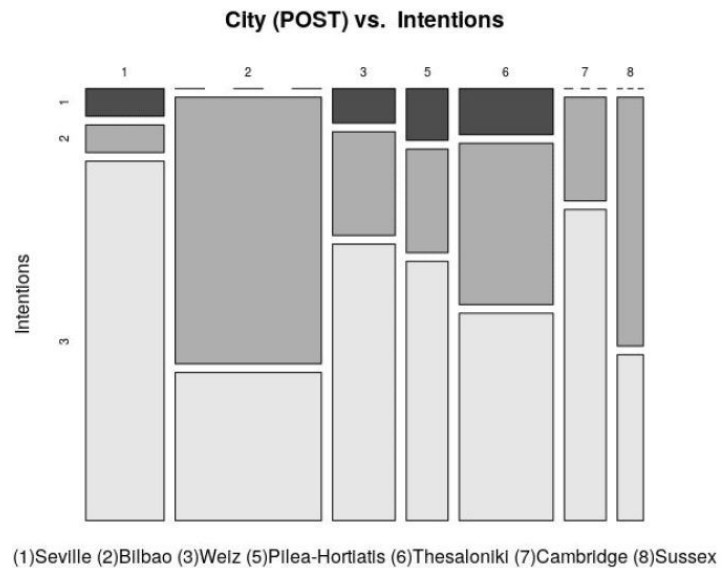
Figure 10. POST-pilot: Comparison of the distribution of intentions in each pilot. Y axis: Pre-Contemplation (1), Contemplation (2) and Action